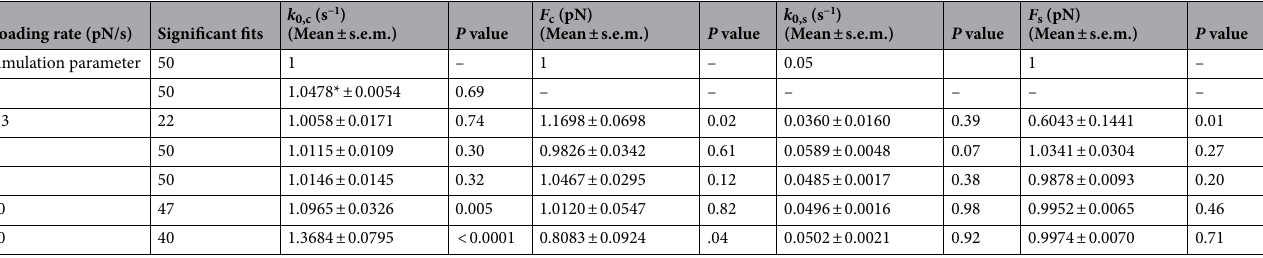
Table 3. Mean fit parameters from simulated catch-slip bond dissociation data sets. Reported values represent the mean ± s.e.m. of the fit parameters for the sets of N = 1000 simulated catch-slip bond dissociations under the increasing load rate for which the fits were significant. The number of significant fits is indicated. In all cases, P values are calculated for two-tailed t-tests. * k off,c-s ( F = 0 ) = k 0,c + k 0,s = 1.05 per Eq. (17) for the parameters used in the